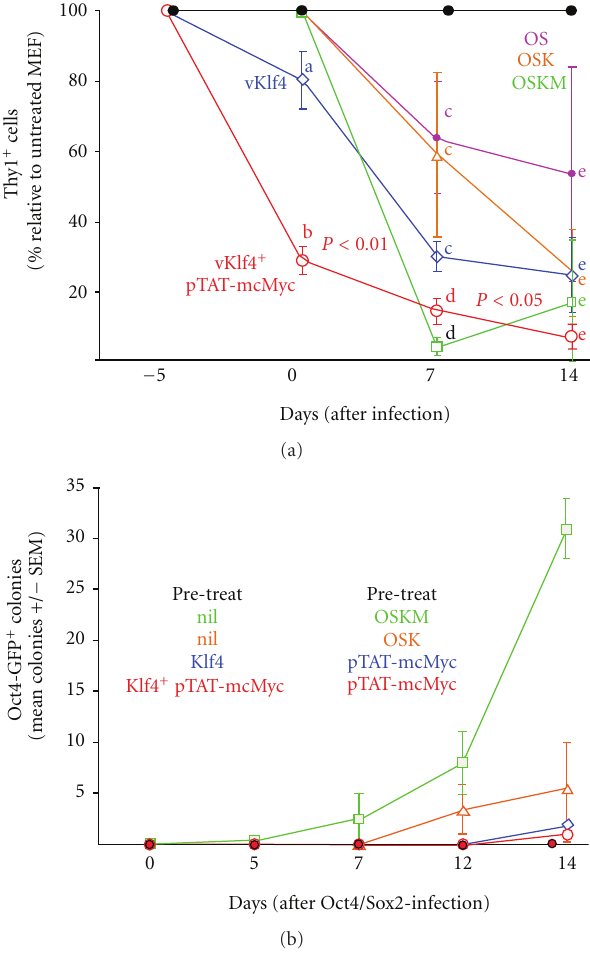
Figure 5: A staggered approach to application of reprogramming factors. (a) MEF were pre-treated with mKlf4 (provirus) ± pTAT- mcMyc protein (or untreated) for 5 days and infected with mOct4 and mSox2 at day 0. Alternatively, MEF were not pre-treated and infected with mOct4+mSox2, mOct4+mSox2+mKlf4 or all four reprogramming factors (OSKM). The percentage of Thy1 + MEF was ascertained relative to untreated MEF at days 0, day 7 and day 14 post-infection. Statistical significance in percentage of Thy1 + MEF was assessed by one-way ANOVA. Mean ± SEM of n = 3 experiments shown. (b) Oct4-GFP + colony counts for experiments outlined in 6A were counted at days 0, 5, 7, 12, and 14 post- infection. Mean ± SEM of n = 3 experiments